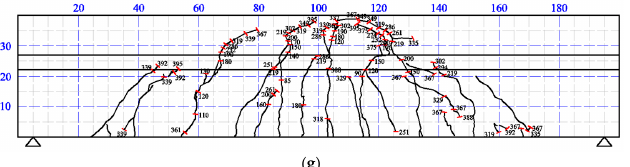
Figure 5. Crack-development distribution of test beams under hydraulic graded loading. ( a ) WS beam; ( b ) ZSS1 beam; ( c ) ZSS2 beam; ( d ) ZSS3 beam; ( e ) DSS1 beam; ( f ) DSS2 beam; ( g ) DSS3 beam.